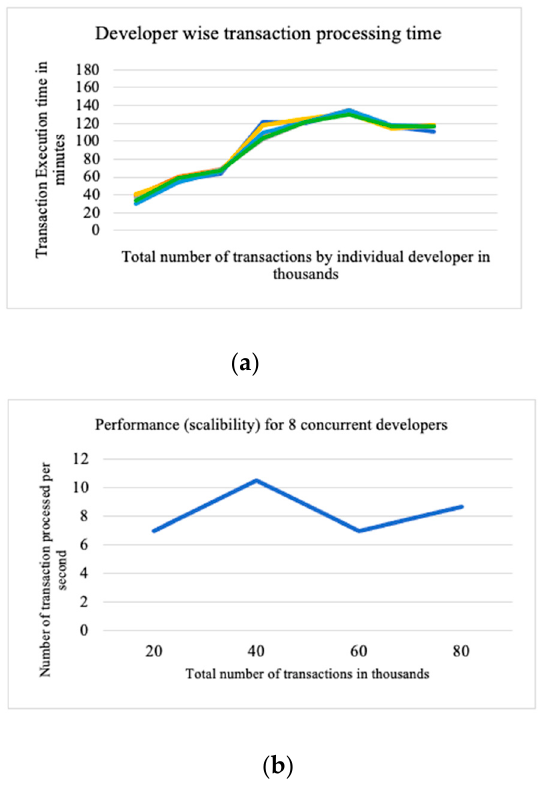
Figure 2. ( a ) Scalability performance for concurrent bidding transactions with up to 8 concurrent developers. ( b ) Transaction processing time for each concurrent developer.